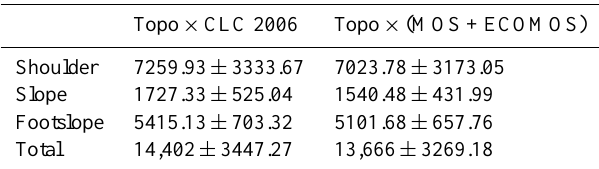
Table 4. Contribution of the three topographic classes to the total N 2 O flux, given for the two upscaling methods based on topography and land use (in kgN 2 O-Nyr − 1 )